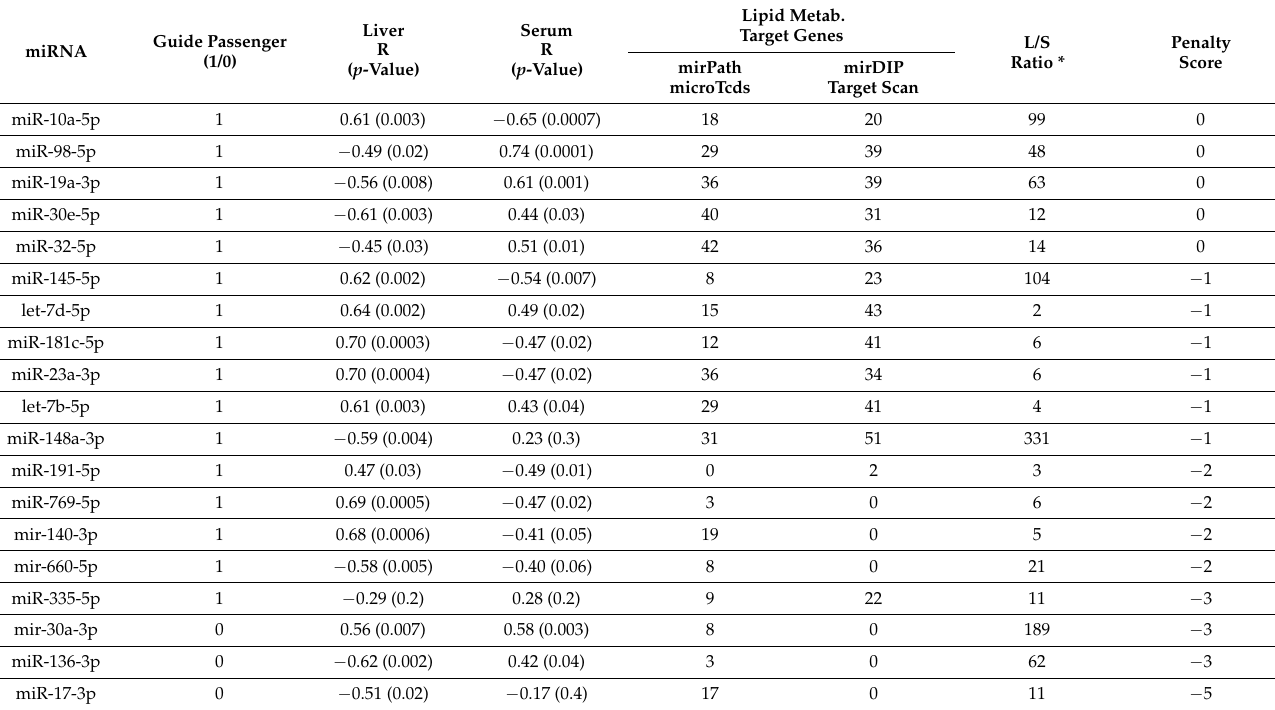
Table 1. Pearson correlation coefficients (R) and biological significance of 19 selected miRNAs.